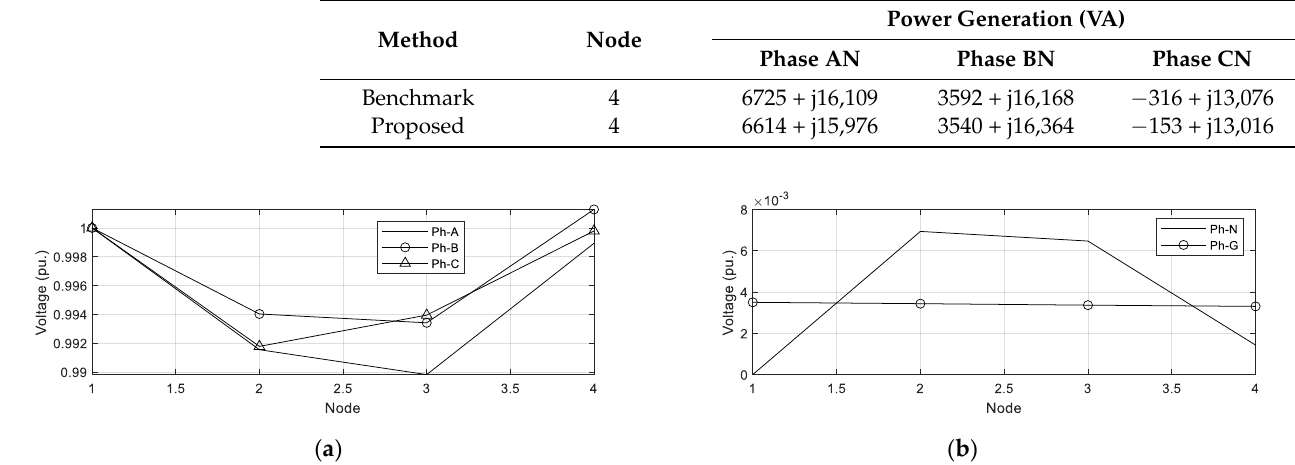
Table 7. Power generation at PV nodes of benchmark and proposed methods.